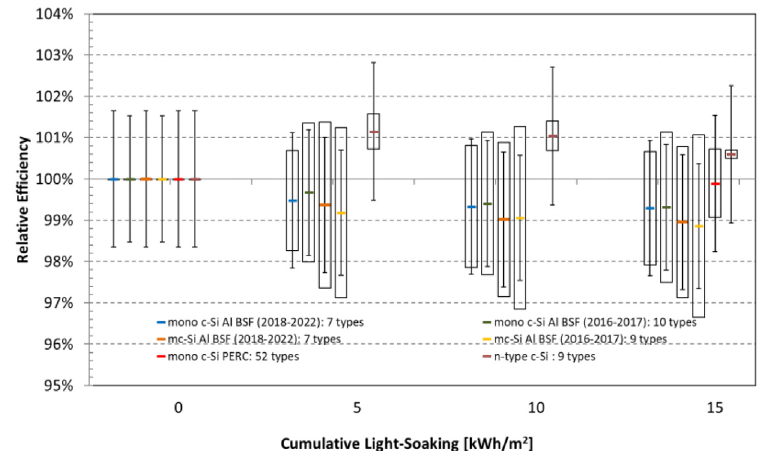
Fig. 2. Light-induced degradation (LID) expressed as relative ef fi ciency (to initial) against cumulative irradiation dose for different module types at STC. Boxes represent the standard deviation of technology variation ( k =2) and error bars represent the measurement uncertainty (